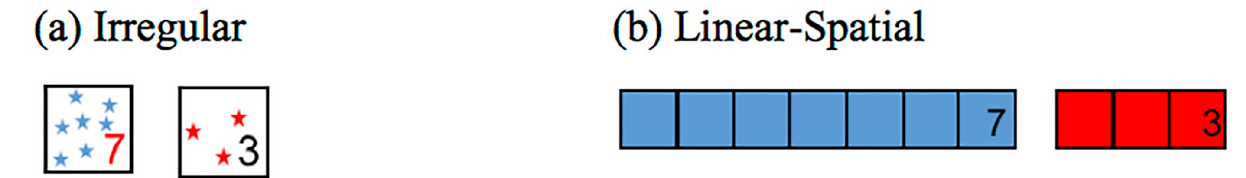
Fig 1. Examples of addend representations used in each condition: (a) irregular and (b) linear-spatial.